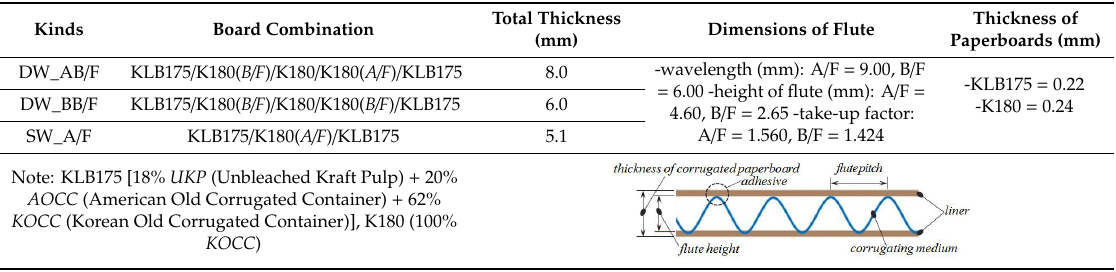
Table 1. Specifications of the target corrugated paperboards.